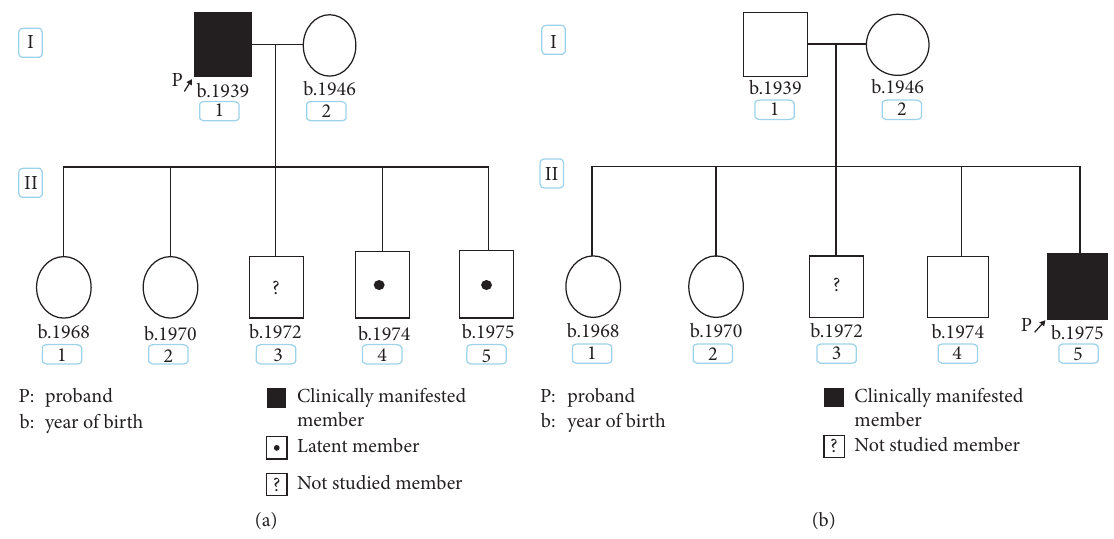
Figure 2: Pedigree of the studied Argentinean family with PCT (a) and AIP (b).